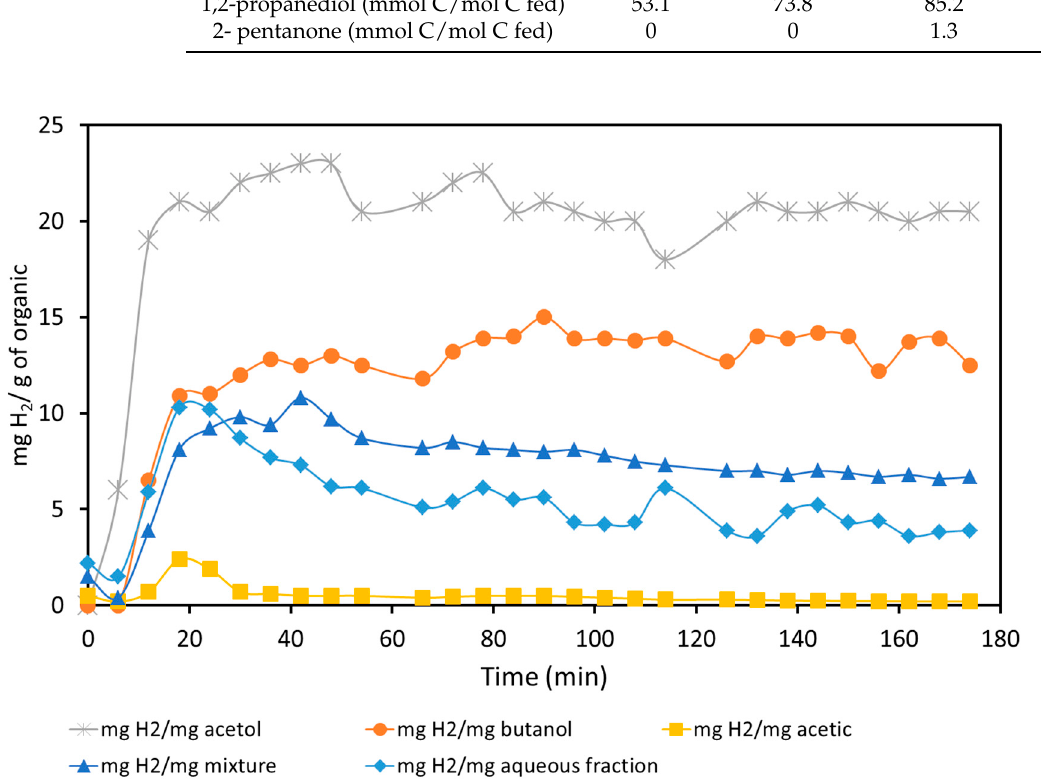
Figure 5. Evolution of hydrogen production with time in the APR of individual compounds, simulated mixture and aqueous fraction of bio-oil. (T = 227 °C, 40 bar, W/m = 40, Ni-Co/Al-Mg catalyst, 1 mL/min aqueous feeding rate).